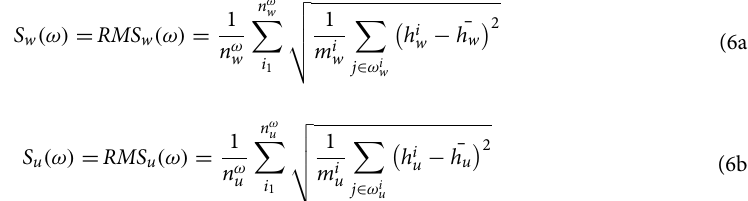
unevenness ( S w (ω) and S u (ω) ) should be individually assessed based on the original definition of RMS without excluding the local trend of a profile, i.e.: